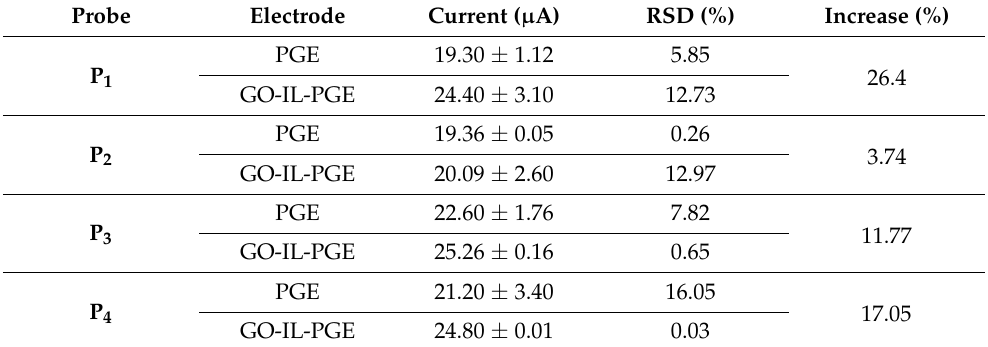
Table 4. The average guanine oxidation signals ( n = 3) and RSD % values recorded by PGE or GO-IL-PGE in case of immobilization of probe (P 1 ), -SH linked (P 2 ), -PO 4 linked (P 3 ), and -NH 2 linked probe (P 4 ). Increase % values were calculated by computing the difference between the signals recorded by PGE and GO-IL-PGE and comparing that difference to the signal recorded by PGE. Probe Electrode